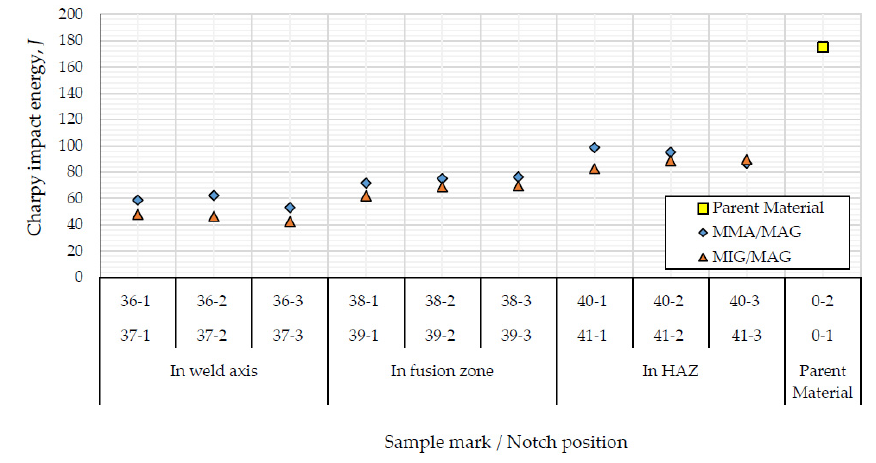
Figure 7. Energy of the test samples with a notch on the face side of the welds.